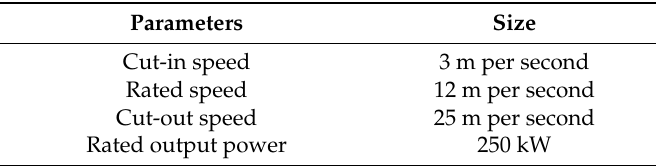
Table 4. Wind turbine characteristics.